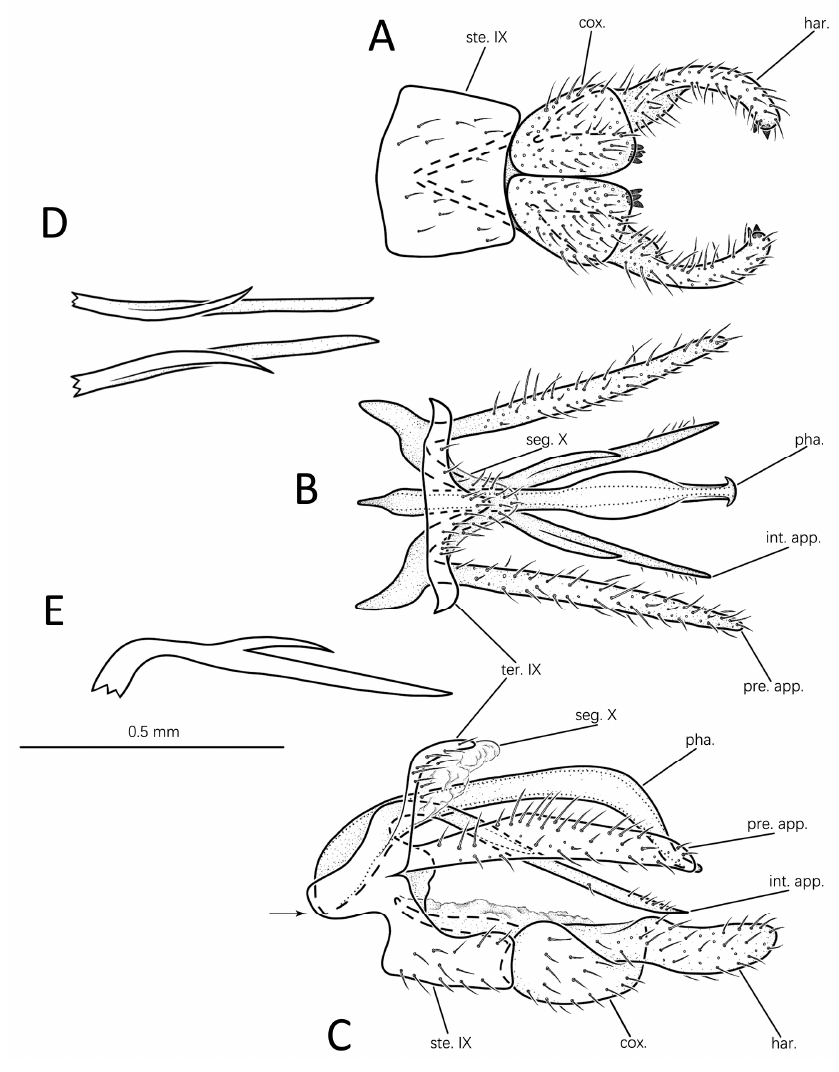
Figure 3. Male genitalia of Eoneureclipsis jianfenglingensis sp. nov.: ( A ) ventral; ( B ) dorsal; ( C ) left lateral; ( D ) intermediate appendages of paratype, dorsal; ( E ) one intermediate appendage of paratype, left lateral. Abbreviations: ste. IX = sternum IX; ter. IX = tergum IX; seg. X = segment X; pre. app. = preanal appendages (paired); int. app. = intermediate appendages (paired); cox. = coxopodite (paired); har. = harpago (paired); pha. = phallic apparatus. Scale bar refers to A–E. 3.1.2. Eoneureclipsis foraminulatus Peng, Zang & Sun, sp. nov. (Figure 4A–C and Figure 7B) Description: Length of each forewing 8.1–8.2 mm (n = 1). Specimen in alcohol with 159